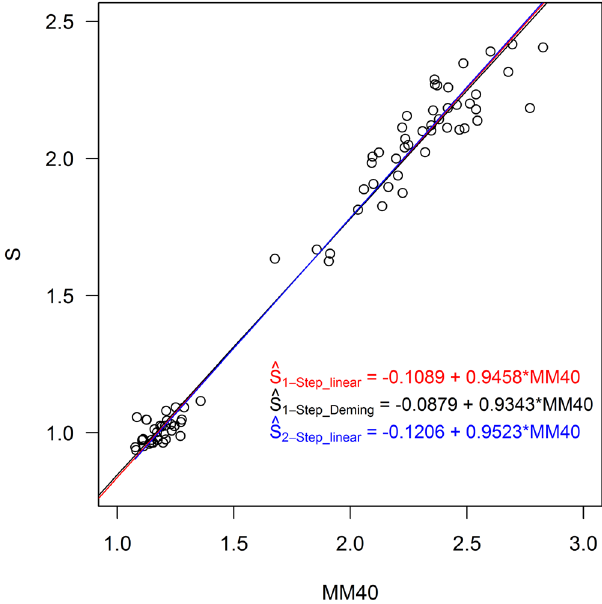
Figure 3. Regression lines computed by using each of the variations in Table 2, shown on the scatterplot between the non-standard method (MM40) and the standard Centiloid PiB method (S). Equations are given in the form in which they would be used to convert MM40 to Ŝ, inverted from their calculated forms that used S as the predictor variable.